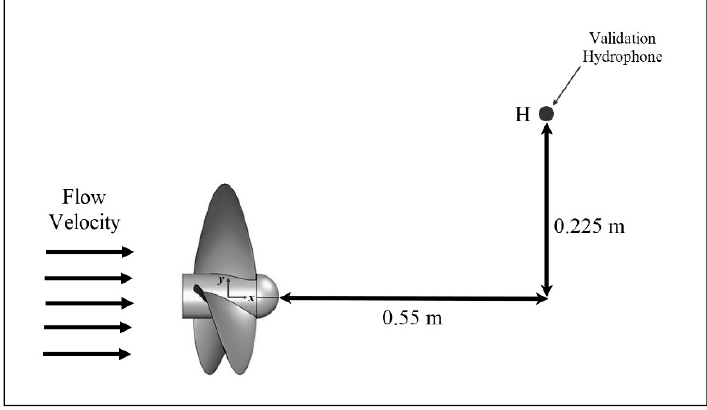
Figure 11. Location of validation hydrophone.